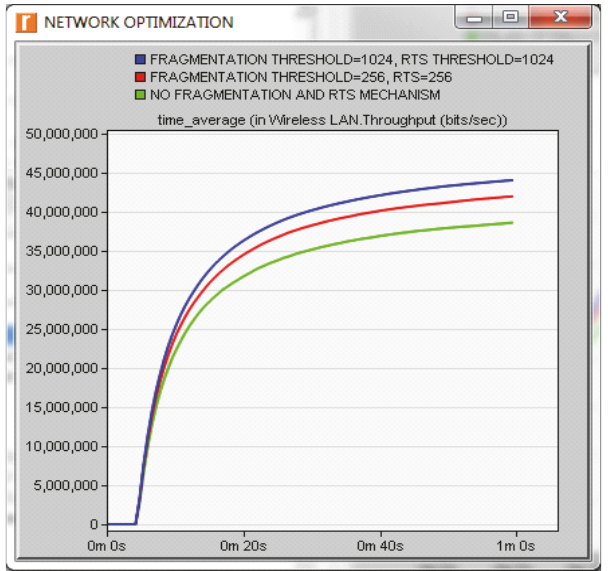
Figure 22: WLAN throughput optimization with different values of RTS and fragmentation thresholds.